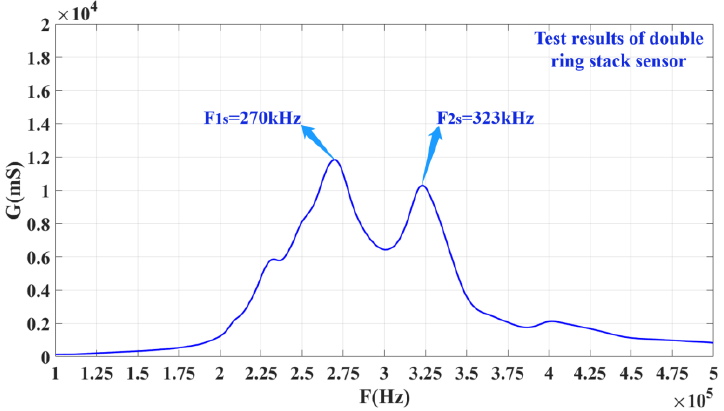
Figure 10. Conductance curves of the stacked sensitive element.